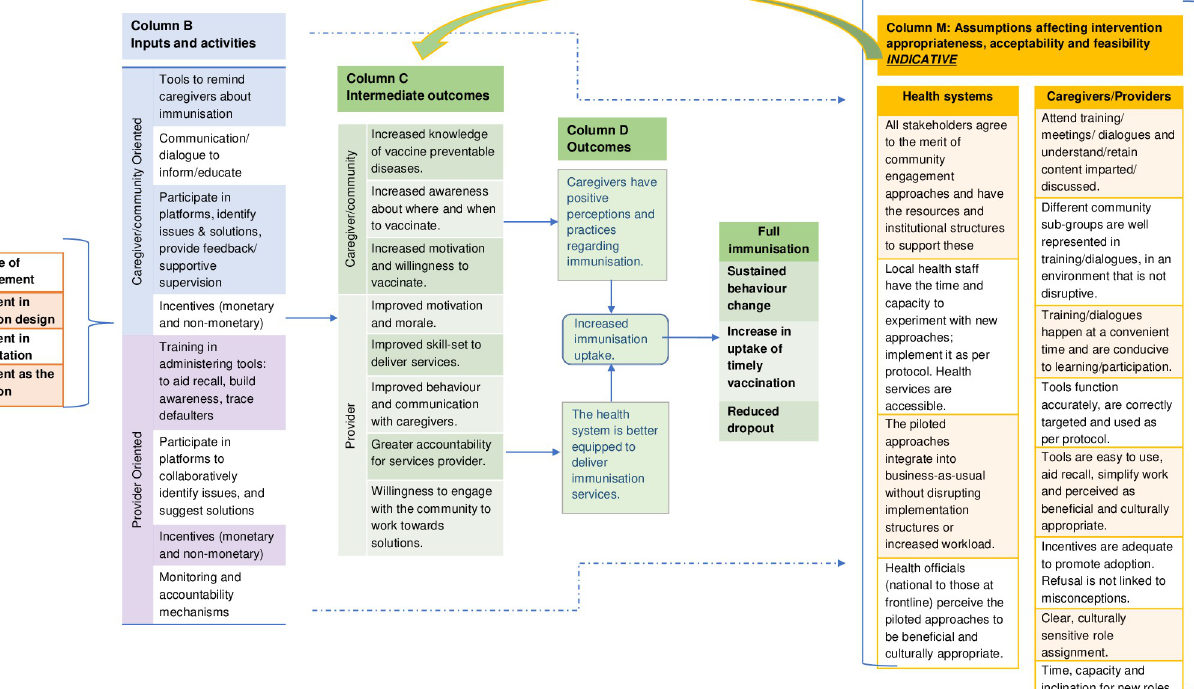
PLOS ONE | https://doi.org/10.1371/journal.pone.0275278 October 7,